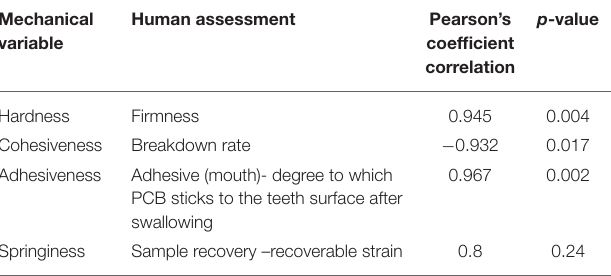
TABLE 7 | Correlation coefficient between human assessment and mechanical variable. Mechanical